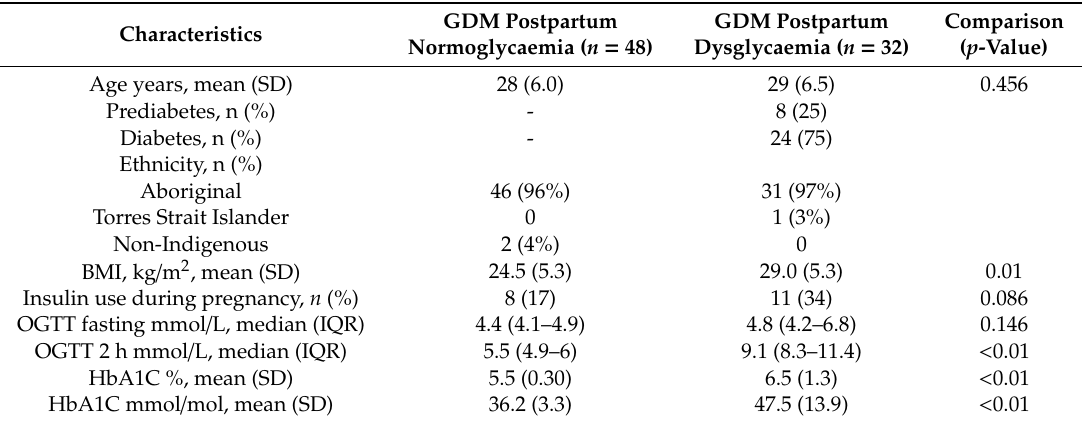
Table 2. Di ff erences between women who did and did not develop postpartum dysglycaemia, among women with GDM who were screened